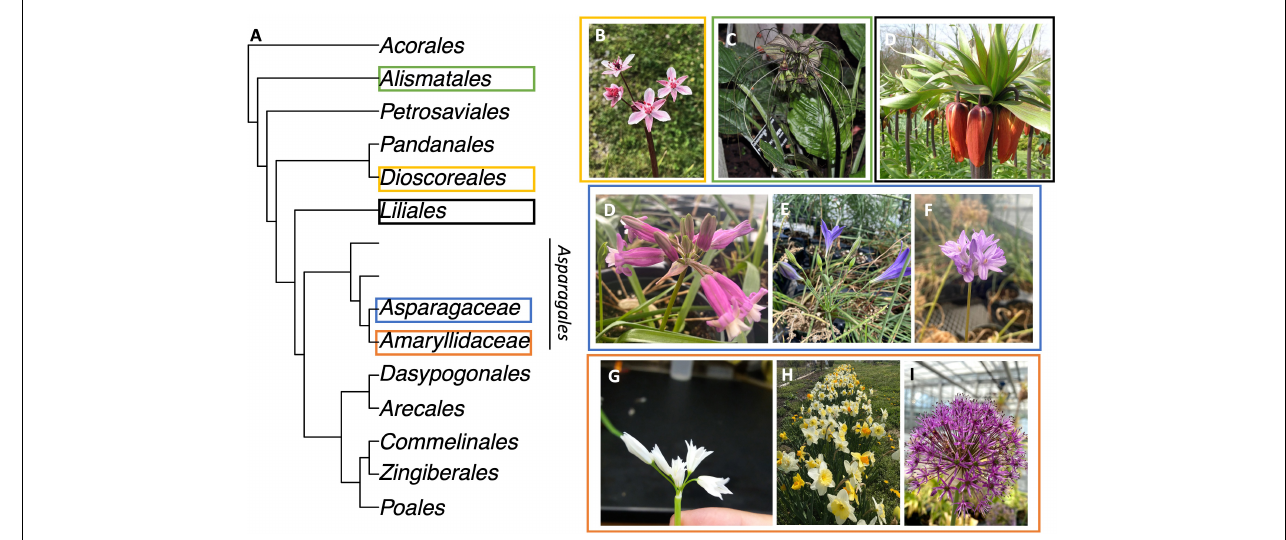
FIGURE 1 | Taxa with Umbellate inflorescence investigated. (A) Order level phylogeny of Monocots following (Givnish et al., 2018). The order Asparagales is separated to show two families studied; the unnamed grade represents the remainder of the families in the order. (B) Butomus umbellatus . (C) Tacca chantrieri . (C) Fritillaria imperialis . (D) Dichelostemma × venustum “Pink Diamond”. (E) Triteleia laxa . (F) Dichelostemma congestum . (G) Allium triquetrum . (H) Narcissus “martinette ”. (I) Allium hollandicum . Colored rectangles correspond between (A–I)